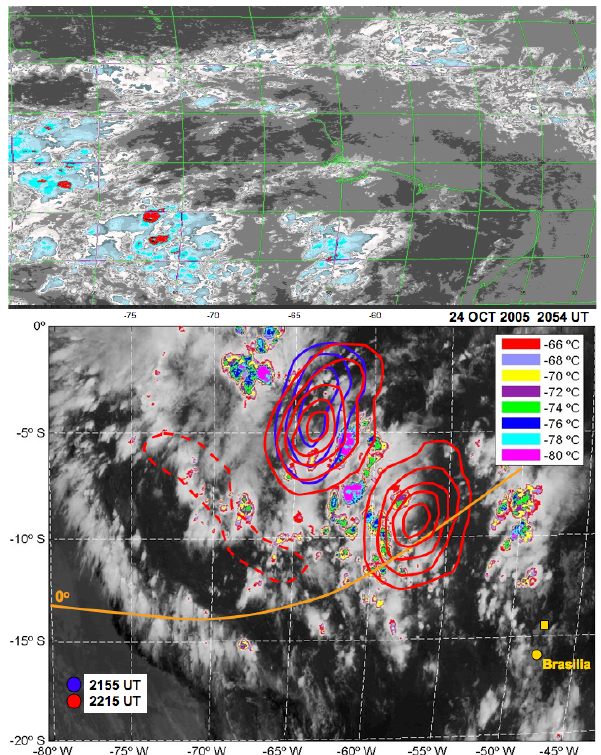
Fig. 3. GOES 12 convection observed in the IR channel at 20:54UT on 24 October 2005. Cloud top temperatures are color coded, with solid (dashed) contours showing positive (negative) zonal GW mo- mentum flux magnitudes at 200km altitude at 21:55 and 22:15UT (blue and red lines). The dominant GW propagation was eastward at this altitude due to primarily westward and large and variable merid- ional winds filtering of GWs initially propagating more isotropi- cally. Note also that the smaller horizontal wavelength GWs have high-altitude signatures earlier and closer to the convective sources than the larger